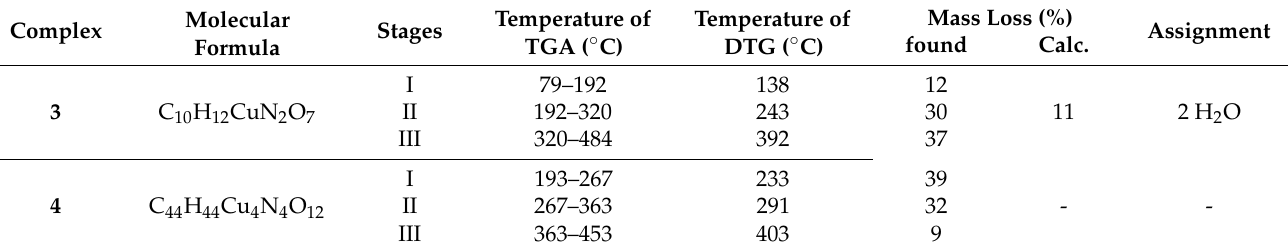
Figure 4. Thermogravimetric (TG/DTG) curves of 4. Table 3. Thermal analytical data for the complexes.